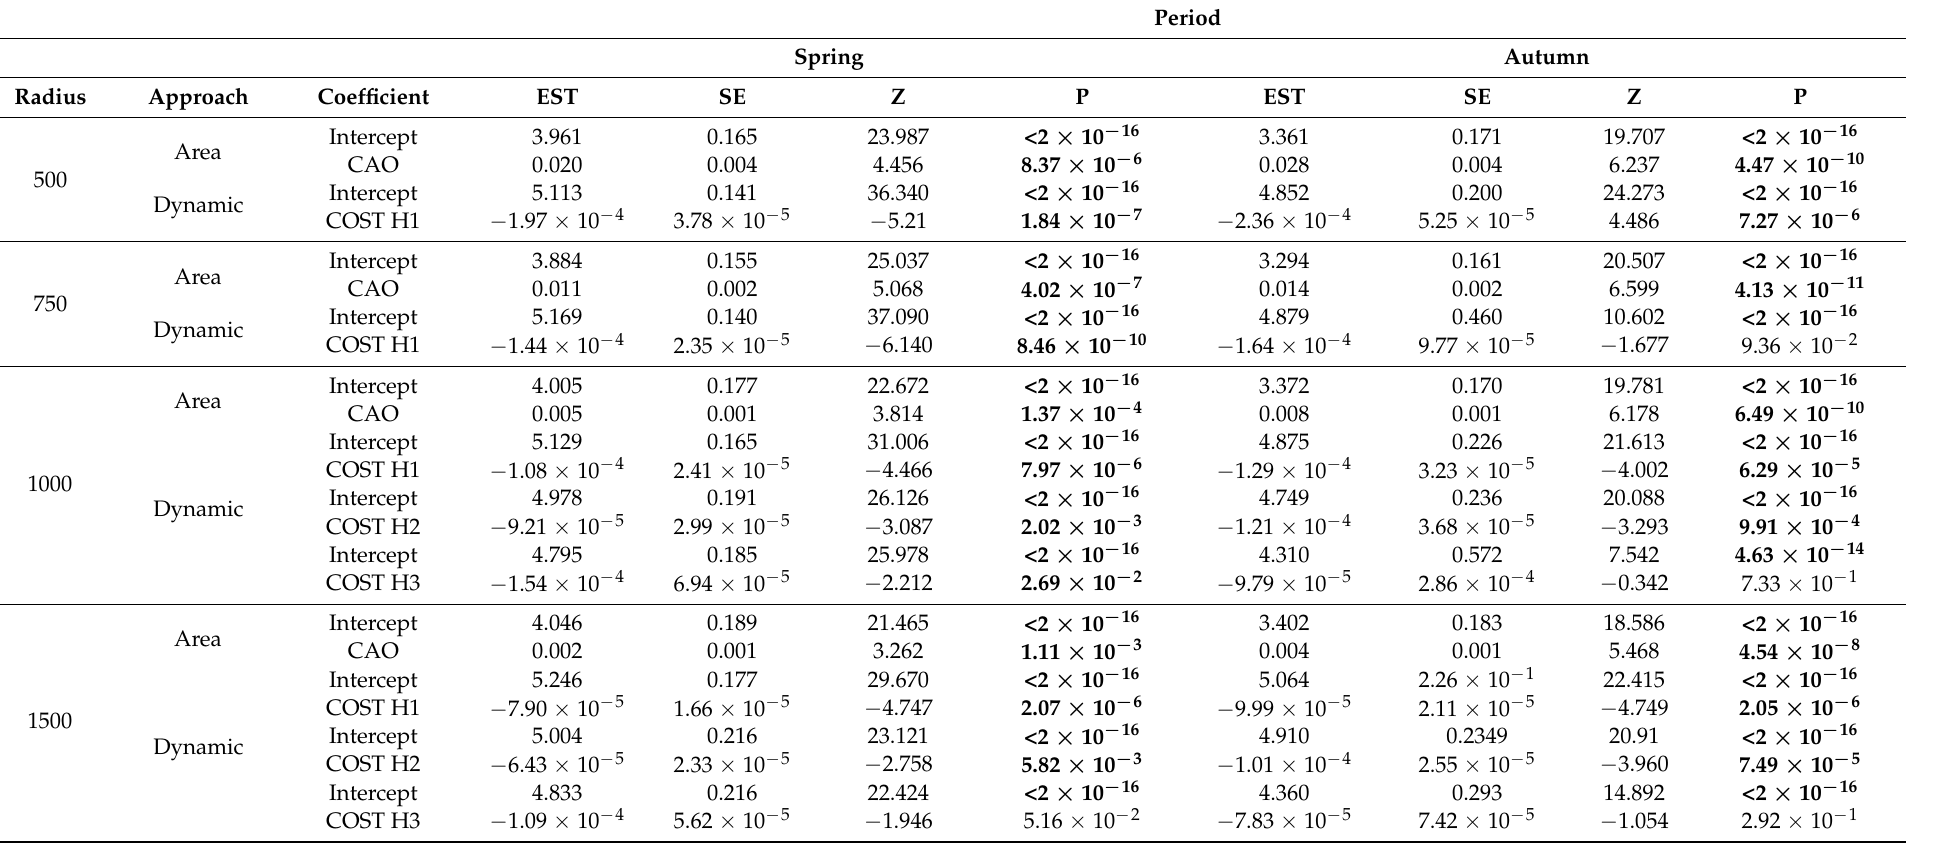
Table 3. Estimated regression coefficients (EST), adjusted standard errors (SE), Z and P values from glmmTMB for comparison of the area and dynamic approaches regarding landscape effect on Bactrocera oleae abundance in 2016. Abundance data were pooled in two periods. Generalized lineal mixed models were fitted with a negative binomial distribution and link function log. Olive grove area (CAO) was used as the explanatory variable for the area approach, and cost–distance (COST) for the dynamic approach. Both CAO and COST were calculated at four radii around the sampled olive groves (500, 750, 1000 and 1500 m). H1, H2 and H3 after COST refer to the hypotheses 1, 2 and 3 respectively (see text for details). p values < 0.05 indicated in